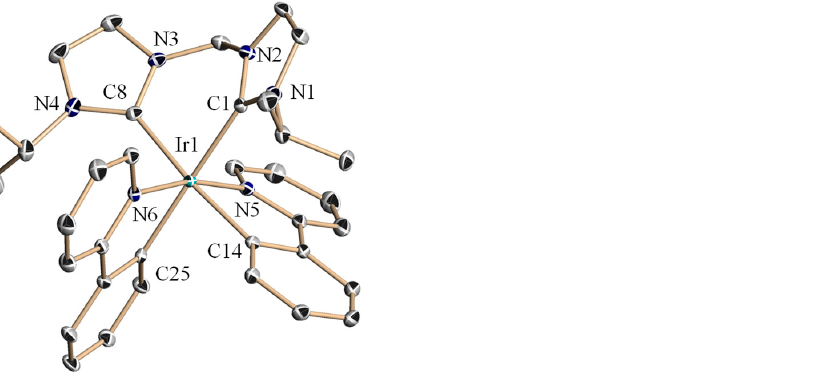
Figure 4. Molecule structure of 4c in the solid state. Hydrogen atoms, non-coordinating anions and disordered dichloromethane are omitted for clarity. Selected distances [Å] and angles [°]: Ir1-C1 2.113(8), Ir1-C12 2.086(10), Ir1-C22 2.055(8), Ir1-C33 2.066(9), Ir1-N5 2.055(8), Ir1-N6 2.056(7), C22- Ir1-N5 80.2(3), C22-Ir1-N6 92.4(3), N5-Ir1-N6 171.5(3), C22-Ir1-C33 81.1(3), N5-Ir1-C33 95.4(4), N6- Ir1-C33 79.3(3), C22-Ir1-C12 100.4(3), N5-Ir1-C12 89.1(3), N6-Ir1-C12 96.4(3), C33-Ir1-C12 175.5(4), C22-Ir1-C1 172.8(3), N5-Ir1-C1 95.0(3), N6-Ir1-C1 91.9(3), C33-Ir1-C1 94.0(3), C12-Ir1-C1 84.9(3). Figure 5. Molecule structure of 4e in the solid state. Only one of two cations presented in the asymmetric unit is shown. Hydrogen atoms, anions, disordered ether molecules and a disorder of one benzyl substituent are omitted and ppy ligands are simplified for clarity. Selected distances [Å] and angles [°]: Ir-C1 2.087(10), Ir-C13 2.161(9), Ir-C23 2.049(8), Ir-C34 2.043(9), Ir-N5 2.041(7), Ir- N62.027(7), N6-Ir1-N5 172.7(3), N6-Ir1-C34 80.4(3), N5-Ir1-C34 92.7(3), N6-Ir1-C23 96.9(3), N5-Ir1- C23 79.1(3), C34-Ir1-C23 77.3(3), N6-Ir1-C1 95.9(3), N5-Ir1-C1 90.1(3), C34-Ir1-C1 165.0(3), C23-Ir1- C1 88.8(3), N6-Ir1-C13 88.7(3), N5-Ir1-C13 94.9(3), C34-Ir1-C13 99.0(3), C23-Ir1-C13 172.7(3), C1-Ir1- C13 95.4(3).